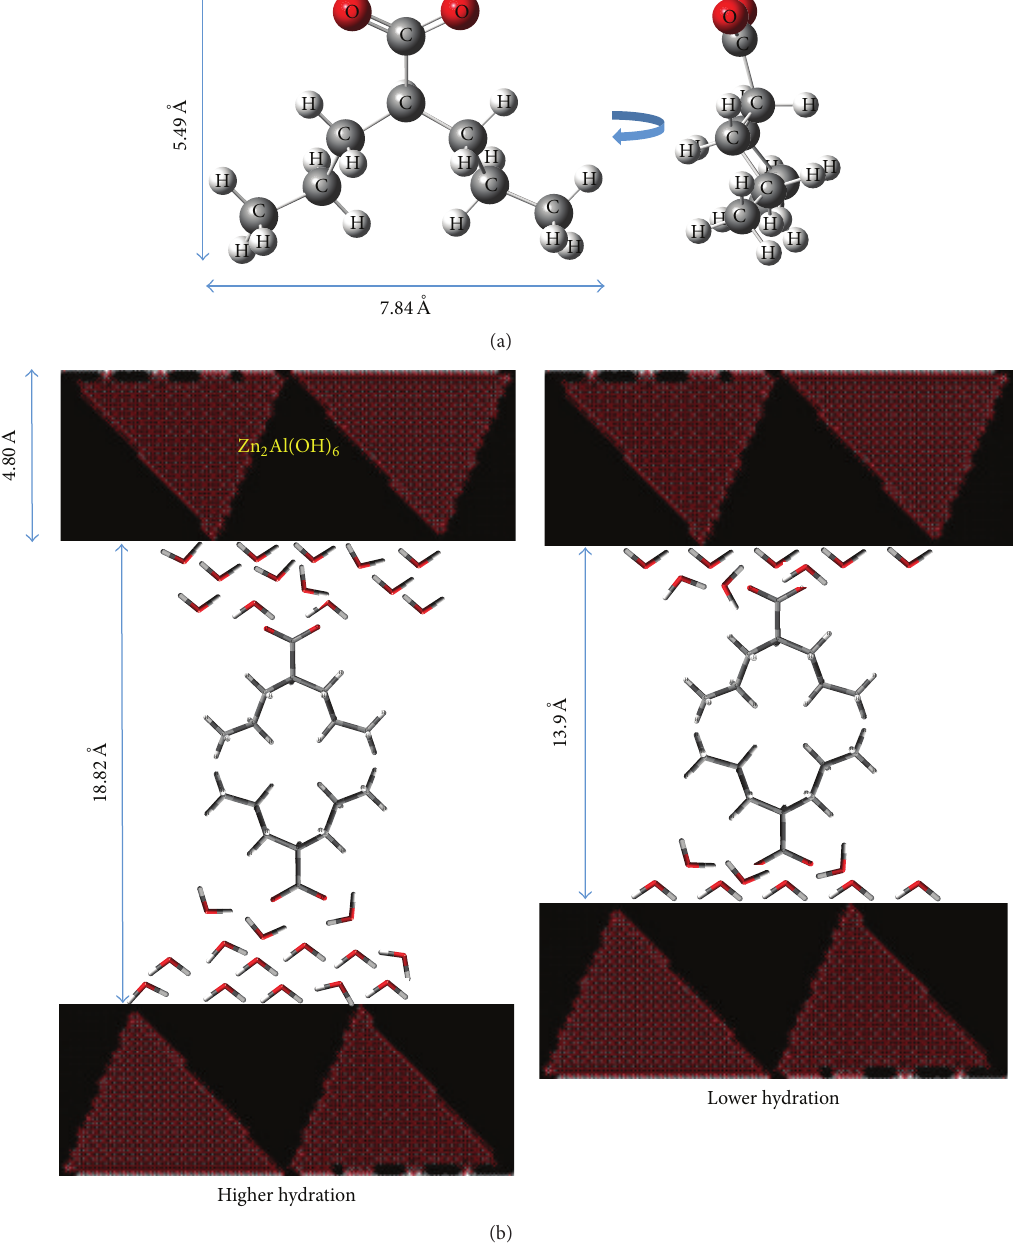
Figure 7: (a) shows GaussView 03 generated 3D representation of the optimized geometry of VP by spin unrestricted B3YLP method using 6-31G ∗ basis set. In (b), the intercalated VP are proposed to be in double layer orientation with different hydration levels according to the interlayer spacing calculated from XRD pattern and the optimized geometry of the